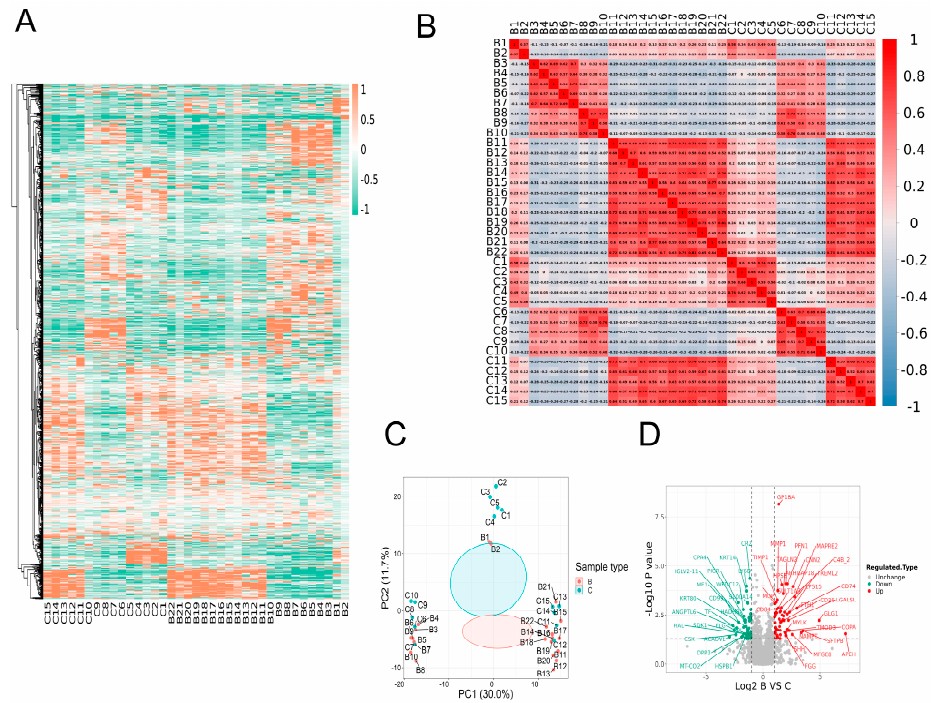
Figure 2. Proteomic profiling of ET patients and healthy controls. ( A ) Heatmap analysis of expression profile of proteins. ( B ) The correlation coefficient matrix of protein. ( C ) Principal component analysis in both groups. ( D ) Proteins are presented by the volcano plot. The vertical dotted lines represent proteins with a more than 1.3 − fold increase (marked with red) or decrease (marked with green), respectively. The gray dots are considered as no significant change, and horizontal dotted lines display cutoff p − values. Table 1. Overview of protein identification.